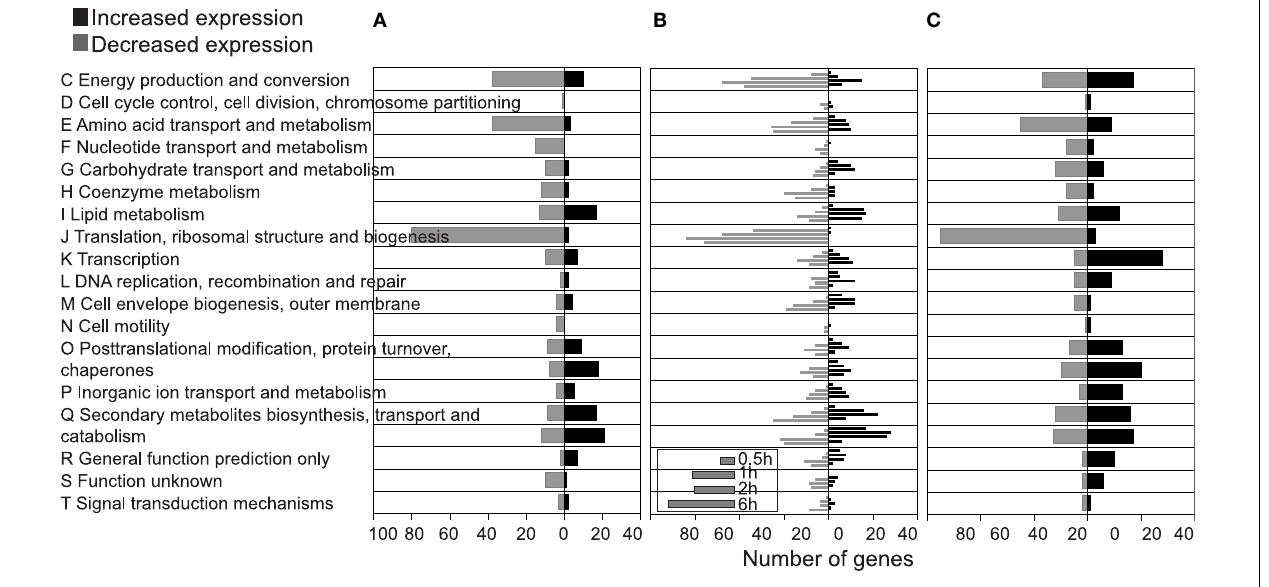
FIGURE 2 | Proportional abundances of differentially expressed genes in conditions of DBF exposure compared to PHE, categorized per COG. (A) Short exposure to DBF in PHE-grown batch cultures, (B) , transient exposure